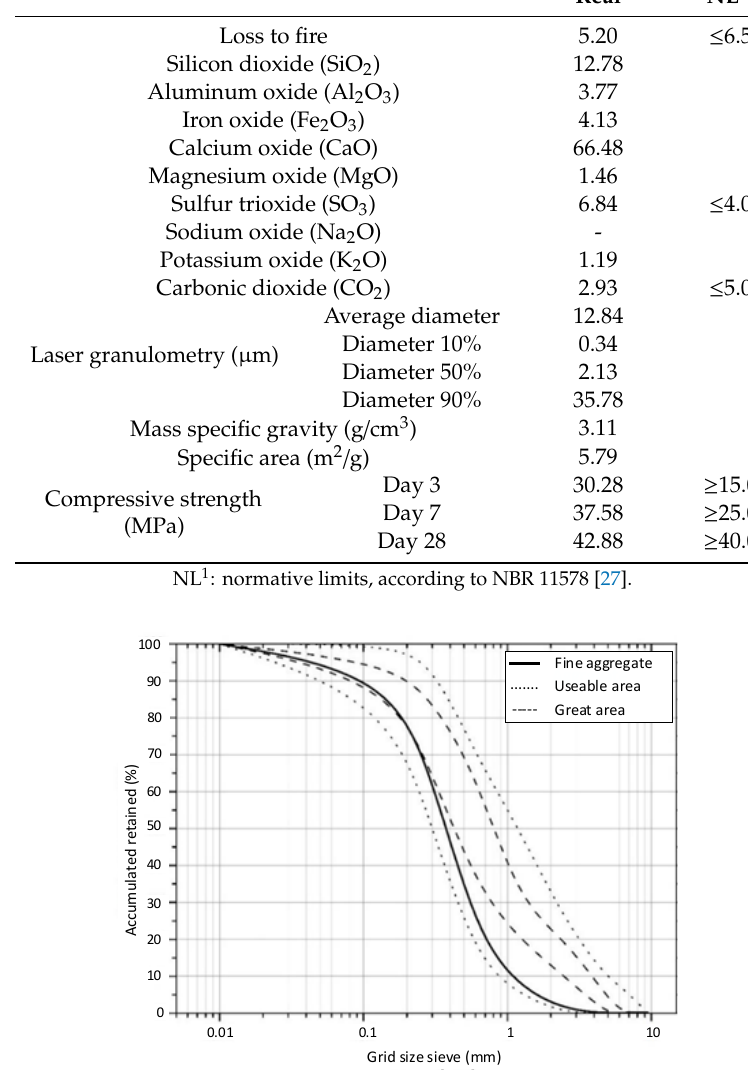
Figure 2. Distribution according to coarse aggregate sieve.